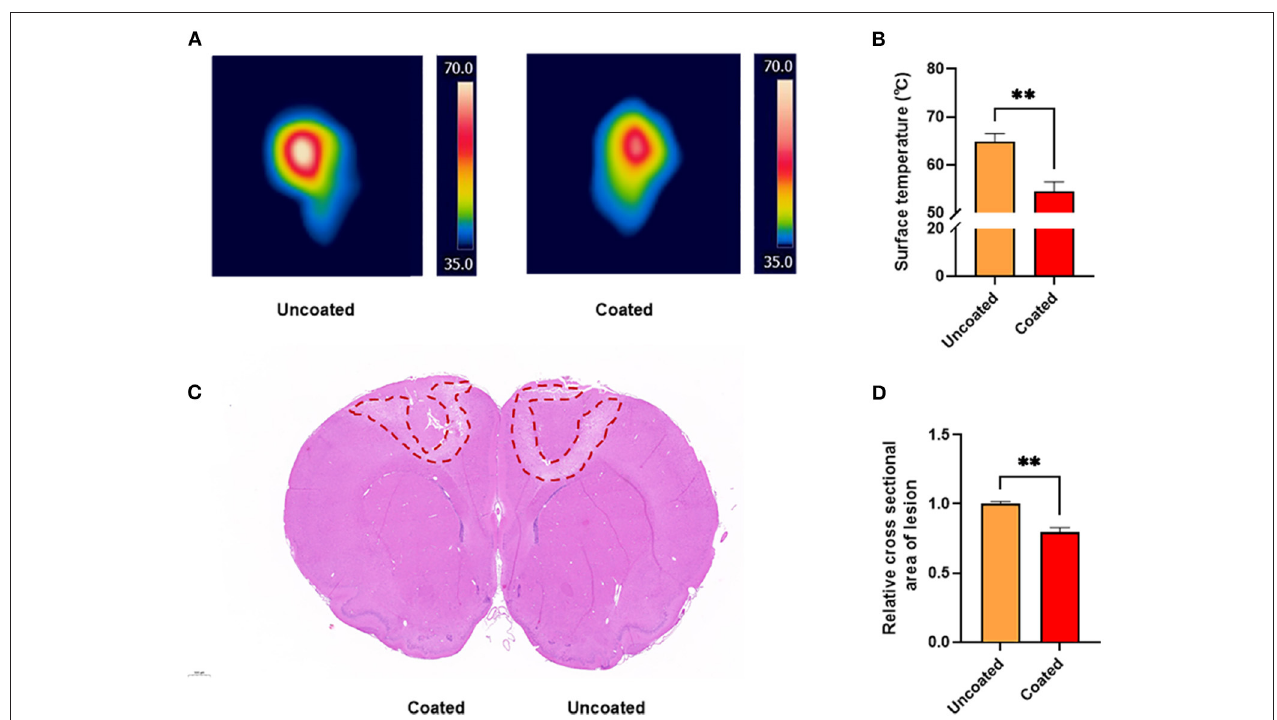
FIGURE 3 | Thermography and thermal damage assessment of the rat primary motor cortex. (A) Thermal images acquired at 3s, 10W unit in vivo rat primary motor cortex studies. (B) Bar graph revealing the highest temperature recorded during electrocoagulation ( n = 6). (C) H&E staining of the cross section of coagulated brain. (D) Bar graph of the relative cross section damaged areas ( n = 3). A 2-tailed unpaired Student’s t -test, ** p < 0.01.